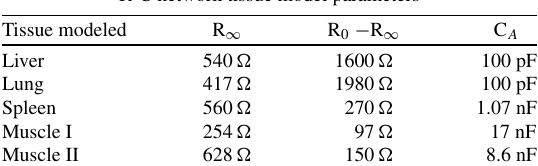
Table 4 R-C network tissue model parameters